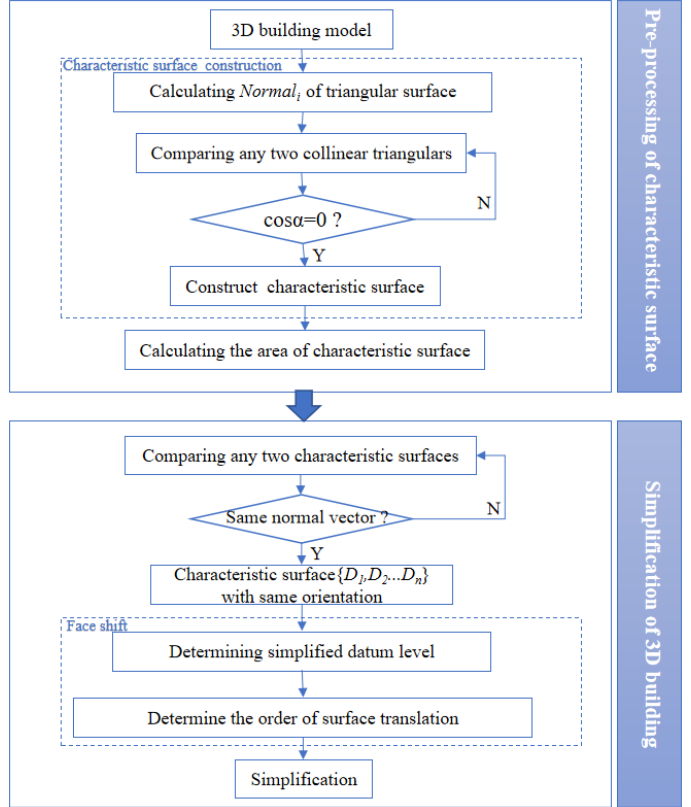
Figure 7. Flowchart of continuous simplification for 3D building models.